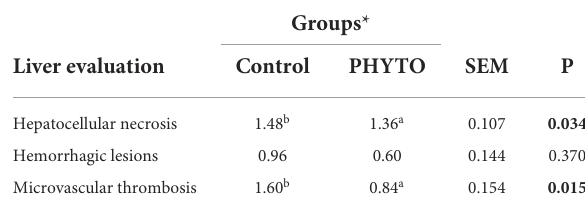
TABLE 4 Effect of dietary supplementation with PHYTO on hen liver evaluation at the 8th week of the